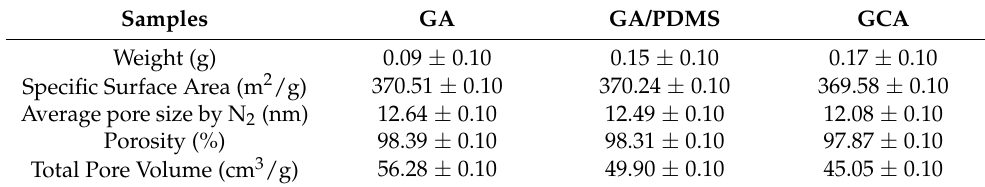
Table 1. The characterization of the graphene aerogels.